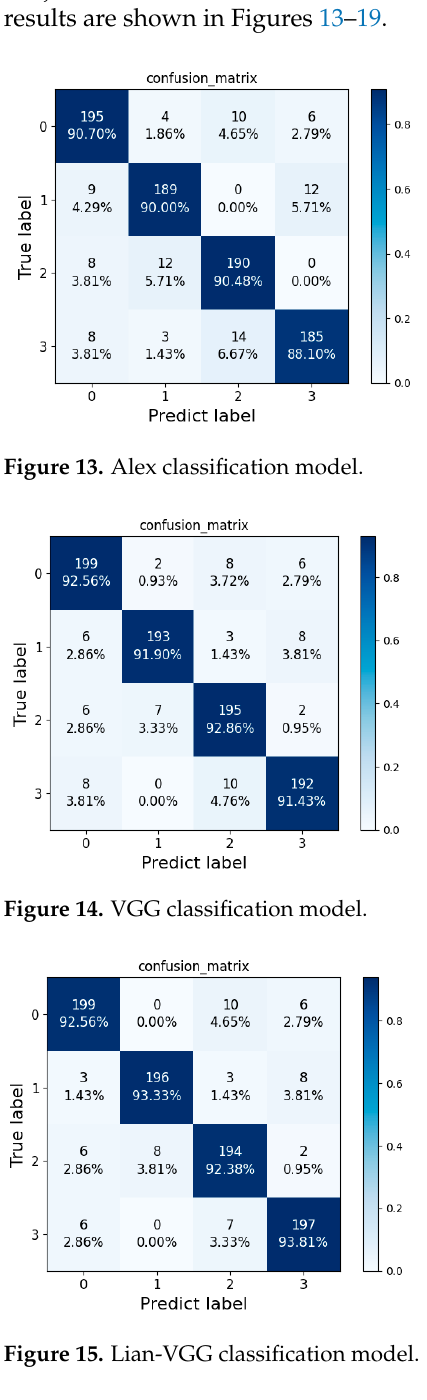
Figure 16. SE-VGG classification model.